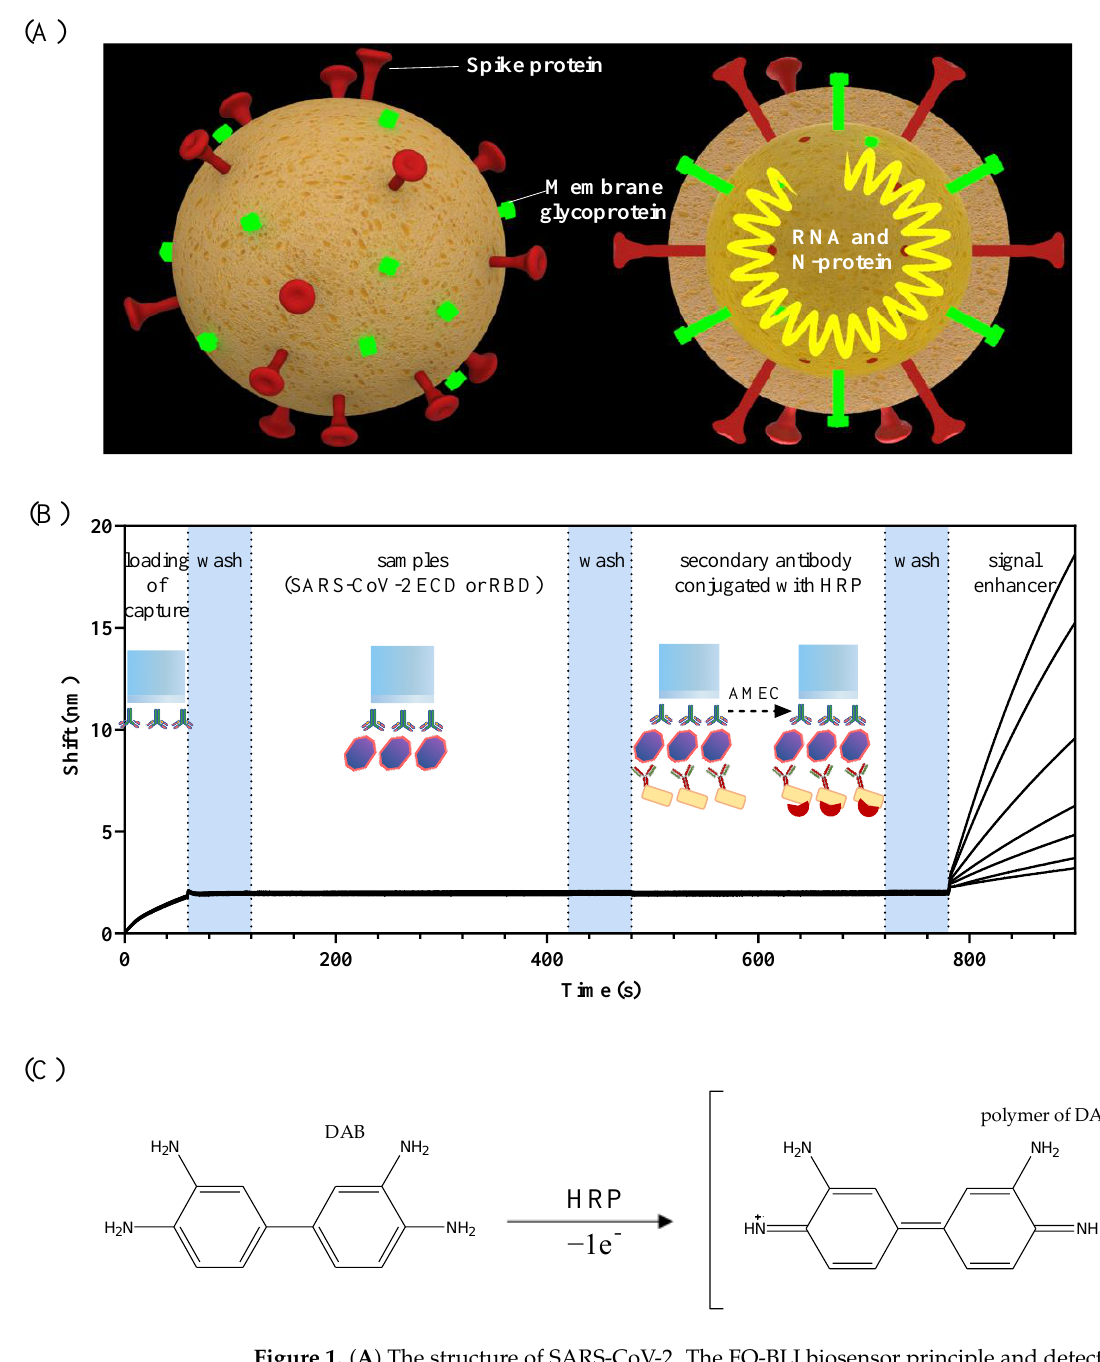
Figure 1. ( A ) The structure of SARS-CoV-2. The FO-BLI biosensor principle and detection flowchart. ( B ) Schematic illustration of the detection flowchart, the sandwich-based assay principle, and the oxidation reaction for signal enhancement on top of a fiber tip. ( C ) Scheme of the reaction between DAB with the HRP enzyme.